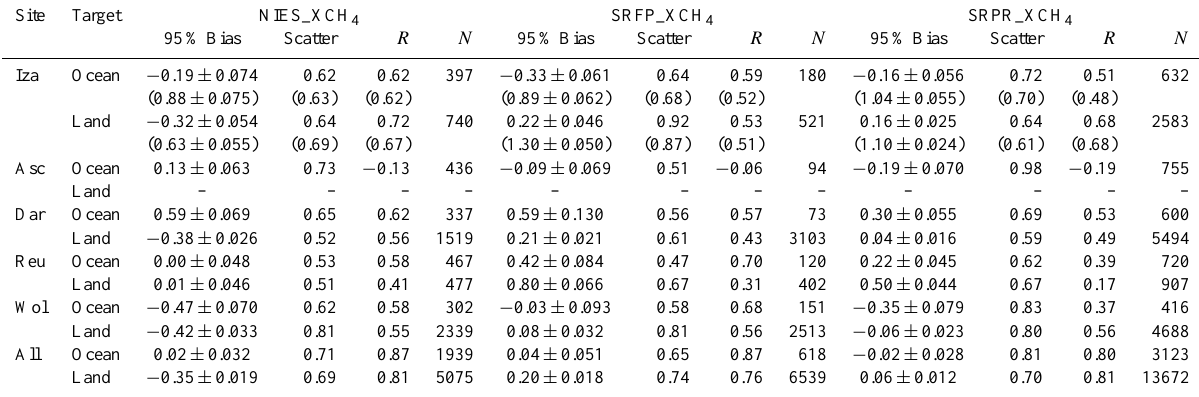
Table 4. XCH 4 results of NIES, SRFP and SRPR algorithms at 5 TCCON stations based on all individual satellite–TCCON data pairs. The 95% confidence interval of relative bias, relative scatter, R and N are defined in Sect. 3.4. Between brackets are the results without altitude correction. Positive/negative bias means the FTIR measurement is less/larger than the GOSAT